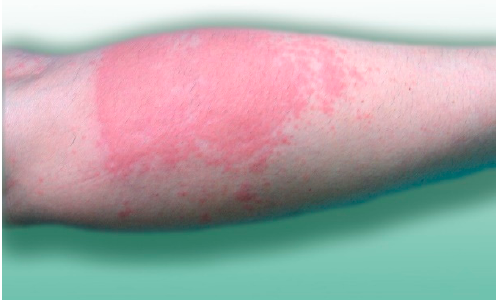
Figure 2. A wide urticarial plaque with small grouped papules as satellite lesions on the lower limb in a 50-year-old woman after blackfly bites.